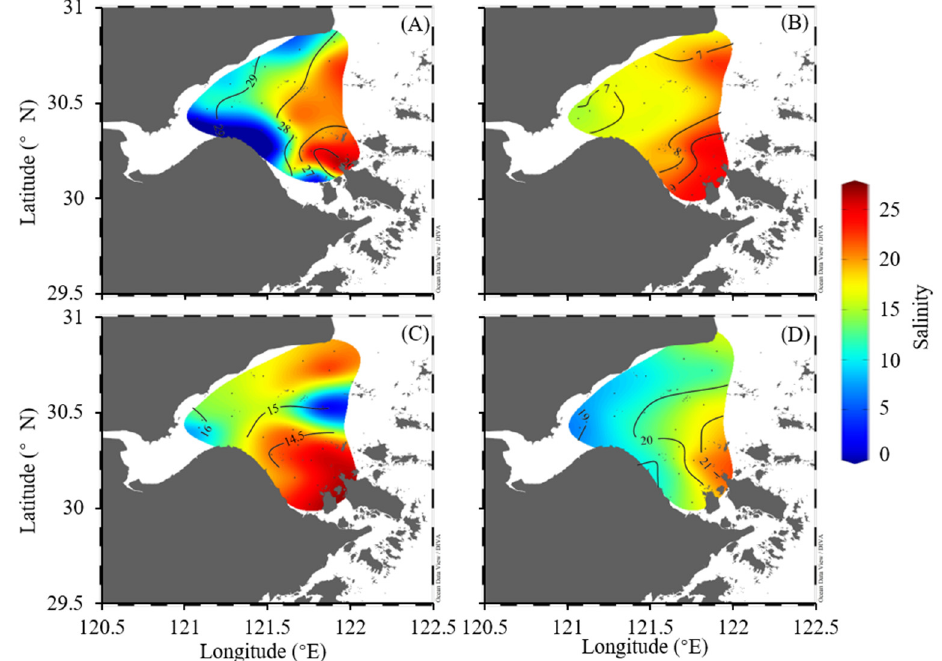
Figure A1. Spatial and temporal variations of surface salinity in ( A ) July 2006, ( B ) December 2006, ( C ) April 2007 and ( D ) October 2007. The black lines are the isolines of surface temperature (°C).